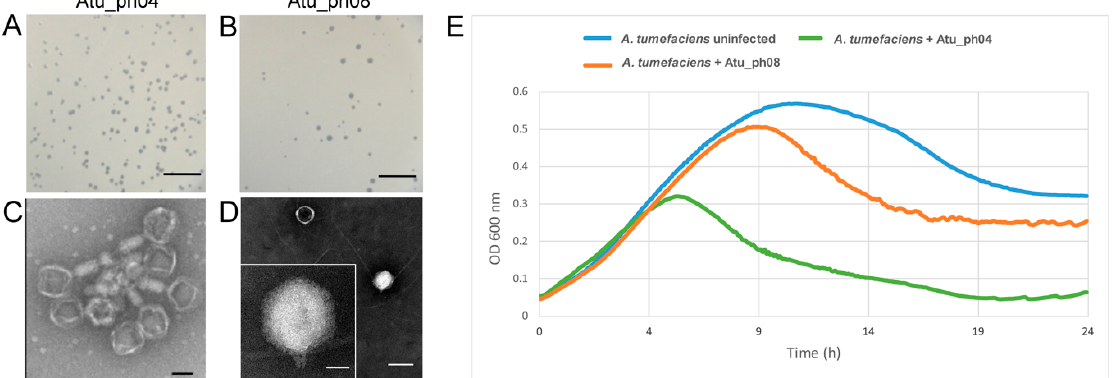
Figure 1. Characterization of Atu_ph04 and Atu_ph08. Plaque assays of Atu_ph04 ( A ) and Atu_ph08 ( B ). Scale bars represent 10 mm. Transmission electron microscopy of ( C ) Atu_ph04 shows it is in the Myoviridae family. Scale bar represents 100 nm. ( D ) Atu_ph08 is in the family Podoviridae . Scale bar (right) represents 100 nm and scale bar in inset represents 25 nm. ( E ) Growth curve of A. tumefaciens C58 cells growing in the presence and absence of phage at an MOI of 0.001.